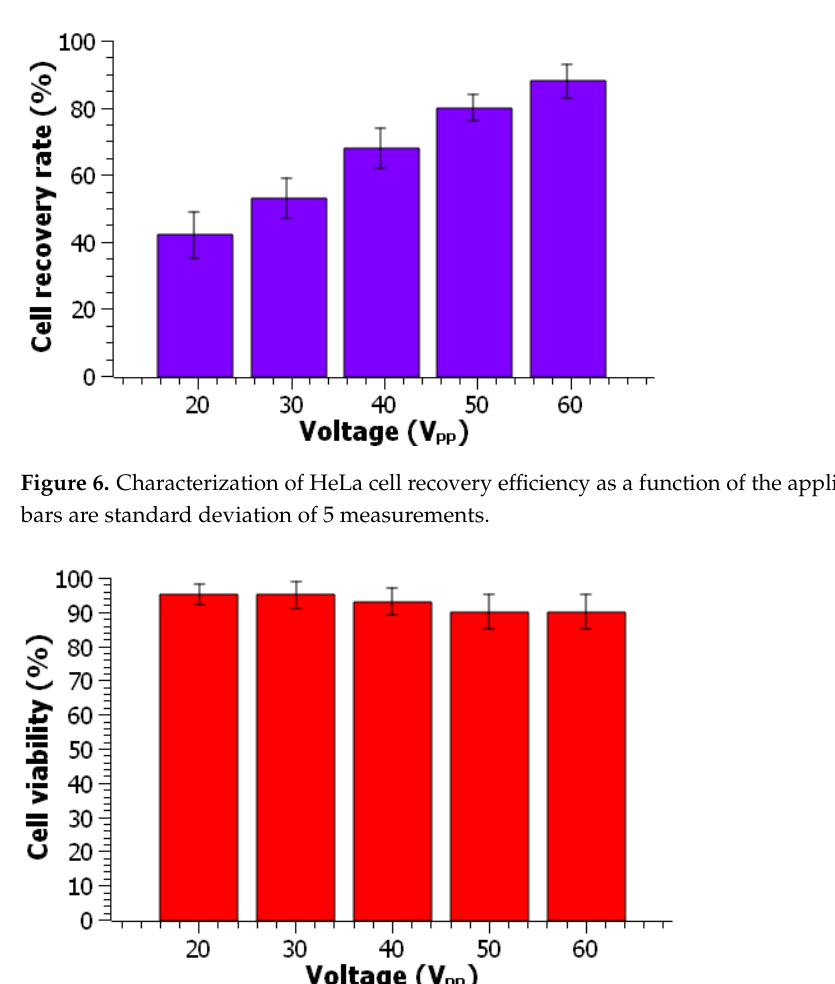
6 of 10 Figure 5 . Separation of HeLa cells and polystyrene particles is shown by stacked images. ( a ) When the acoustic field is turned off, the mixture of the particles and cells flow together. ( b ) In the standing acoustic wave field, HeLa cells mostly follow the pressure nodes and separated from the smaller polystyrene particles. The deflection of the HeLa cells needs to be high enough to separate them from the particles and cell debris and push them to the lower outlet. For this, increasing power amplitudes were applied and for each case number of HeLa cells recovered from the orig- inal solution was characterized as shown in Figure 6. Starting from 20 V PP , the applied voltage was increased up to 60 V PP which was the highest voltage provided by the ampli- fier circuit. At the highest voltage, over 88% HeLa cell recovery was obtained at around 92% cell purity. Cell recovery rate is calculated by the ratio of the number of the sorted target cells and the number of the target cells available for separation. Cell purity is de- fined as the ratio of the number of the target cells isolated and the total number of the cells and particles isolated. Cell viability is defined as the ratio between the difference of total number of cells – stained cells and the total number of cells. Here, the stained cells are the